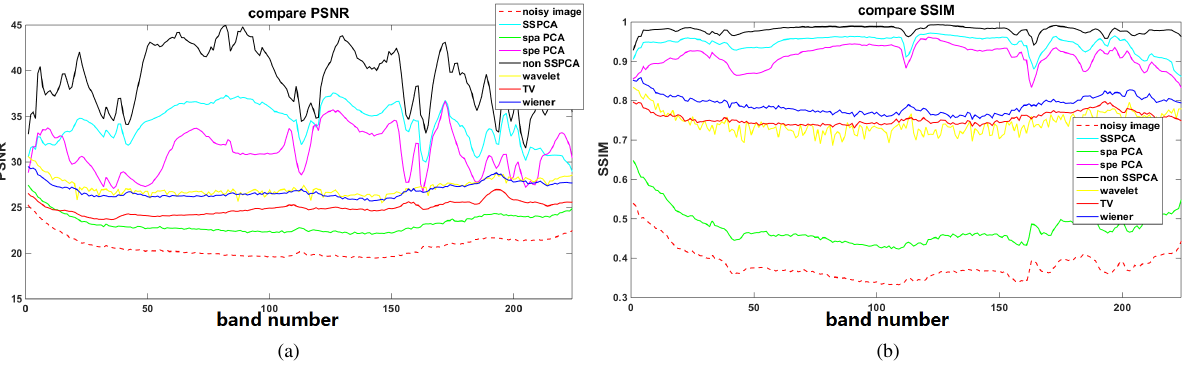
Figure 2. PSNR and SSIM values of the different denoising approaches in each band of the simulated experiment. (a) PSNR. (b) SSIM value. The lines of nonlocal SSPCA above those of the other methods, indicating that nonlocal SSPCA outperforms the other methods in term of both noise removel and detail preservation. The secord best method seems to be SSPCA, and followed closed by spectral PCA. Spatial PCA achieves the lowest PSNR and SSIM lines among all methods. Wiener, wavelet and TV methods comparable performance, but wiener have a high SSIM value.